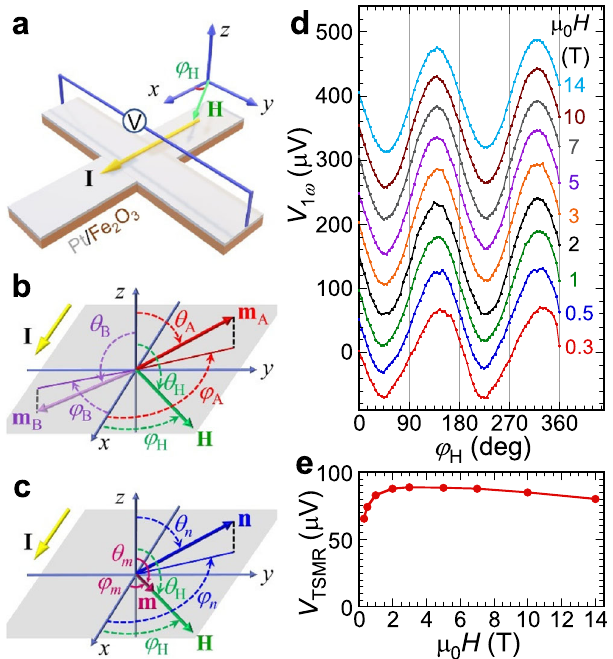
Fig. 1 Experimental geometry and fi rst harmonic results. Schematics of a a Pt/ α -Fe 2 O 3 Hall cross with a 5 μ m channel width, b two spin sublattices m A ð B Þ , and c unit vector of Néel order n and net magnetization m of α -Fe 2 O 3 in the presence of an in-plane magnetic fi eld H within a spherical coordinate system with polar angle θ and azimuthal angle φ for each of the vectors: m A (red), m B (purple), n (blue), m (magenta), and H (green). d In plane angular dependence of fi rst harmonic Hall voltage V 1 ω for a Pt(5nm)/ α -Fe 2 O 3 (30nm) bilayer at different magnetic fi elds from 0.3 to 14T at 300K. e Field dependence of transversespinHallmagnetoresistancevoltage V TSMR extractedfromthe fi tting in d by Eq.